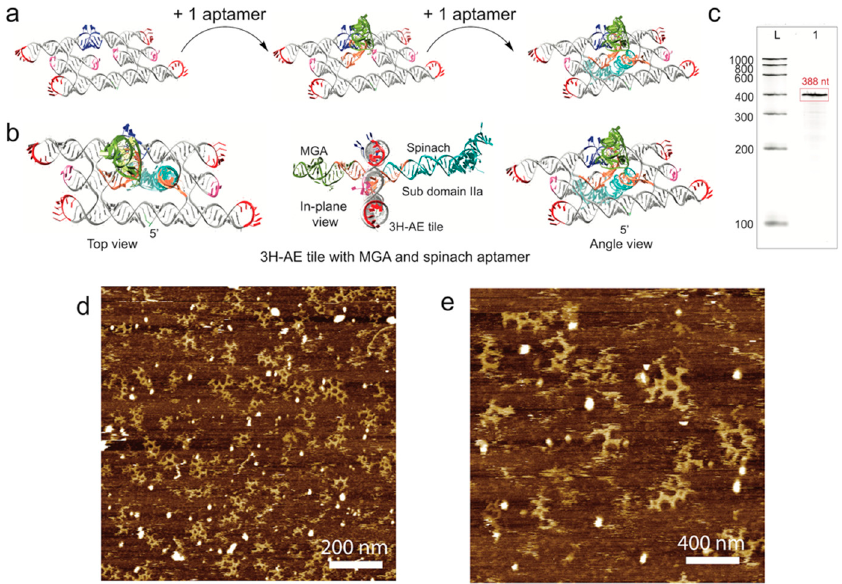
Figure 3. Modification of the MGA functionalized 3H-AE tile with an additional Spinach aptamer (resulting in 3H-AE-MGA-Spinach). ( a ) schematic representation of the addition of MGA (green) and Spinach aptamer (cyan) to the 3H-AE RNA tile connected via subdomain IIa (orange); ( b ) different views of 3H-AE-MGA-Spinach; ( c ) denaturing PAGE gel showing the correct length of 3H-AE-MGA-Spinach. L: LowRange RiboRuler, 1: 3H-AE-MGA-Spinach (388 nt); ( d , e ) AFM images corresponding to different areas of imaging—1 µ m × 1 µ m and 0.5 µ m × 0.5 µ m, respectively.